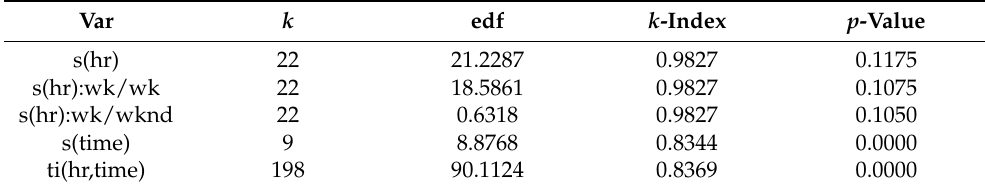
Table 4. K-check for non-spatial